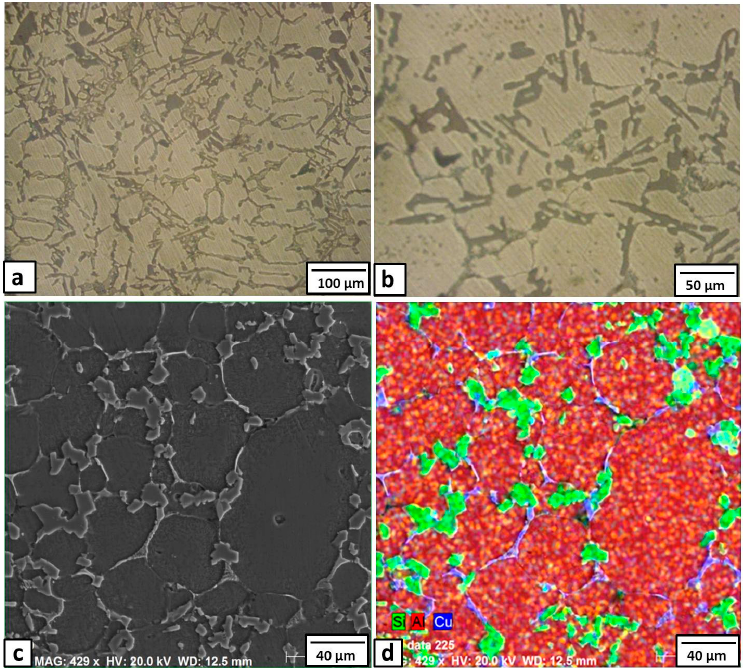
Figure 1. Optical micrographs of the Al-12% Si; ( a ) base metal; ( b ) base metal +3% Cu; ( c ) enlarged scanning electron microscope (SEM) image of base metal +3% Cu; and ( d ) EDS element analysis of image ( c ).